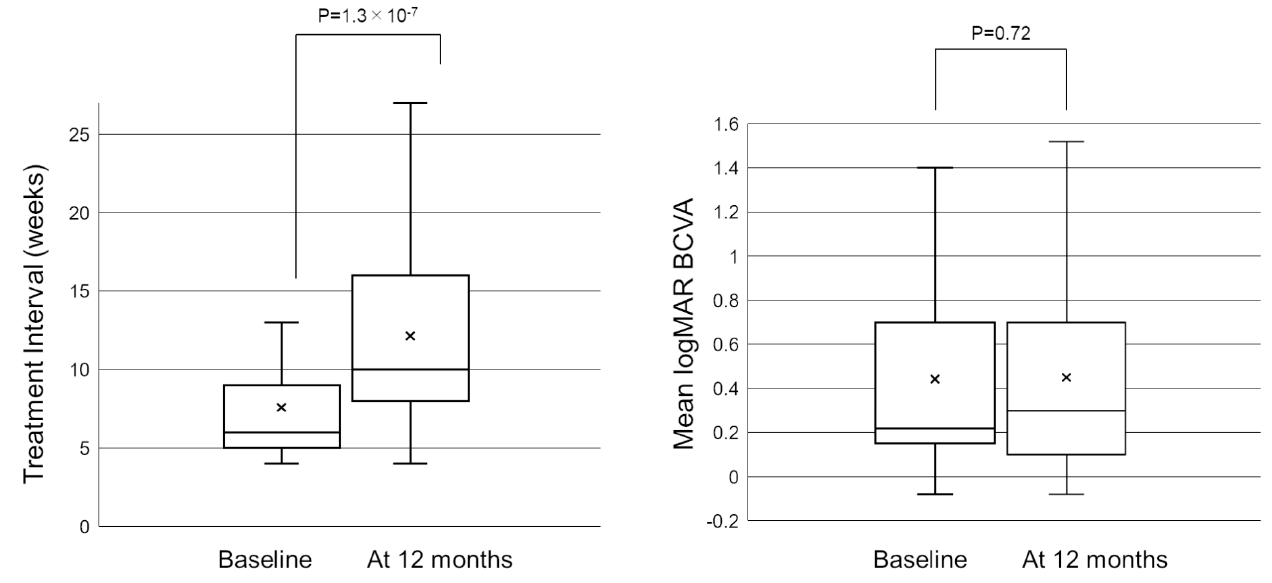
Figure 1. Box − and − whisker plot of mean and median treatment interval and best − corrected visual acuity (BCVA) before and after switching to brolucizumab. The “x” marks in the boxes indicate the mean treatment interval/BCVA. The horizontal lines in the boxes indicate the median treatment interval/BCVA, and the top/bottom edges of the boxes indicate the 25/75 percentile. The top/bottom edges of the whiskers indicate maximum/minimum values. ( Left ) At 12 months, the mean treatment interval significantly extended from 7.6 ± 3.8 weeks to 12.1 ± 6.2 weeks ( p = 1.3 × 10 −7 ). ( Right ) The mean logMAR BCVA was 0.44 ± 0.39 at baseline and was maintained to 0.45 ± 0.43 at 12 months after switching ( p = 0.72). BCVA, best-corrected visual acuity; logMAR, logarithm of minimal angle resolution.